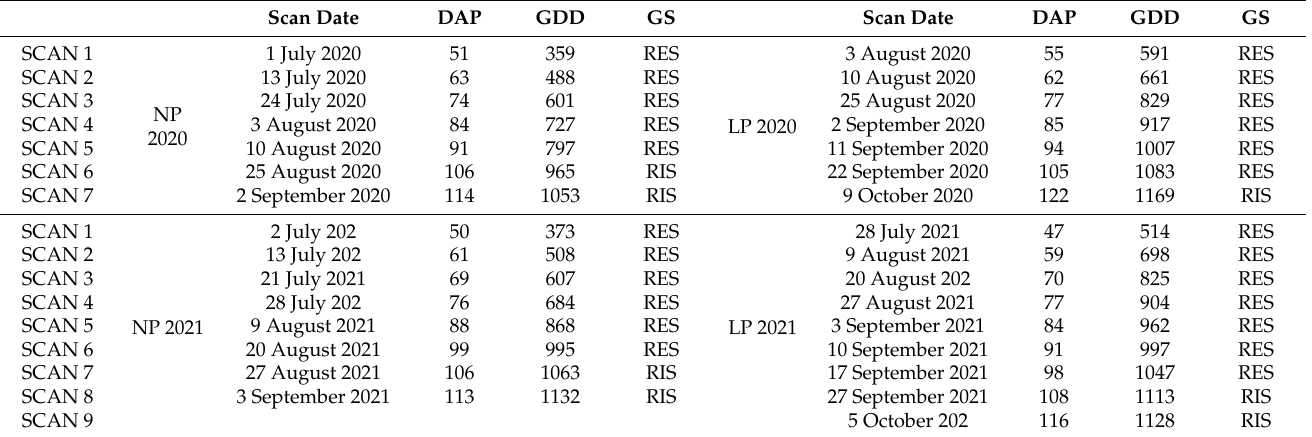
Table 3. Temporal distribution of the proximal sensing data during the sesame growing period.